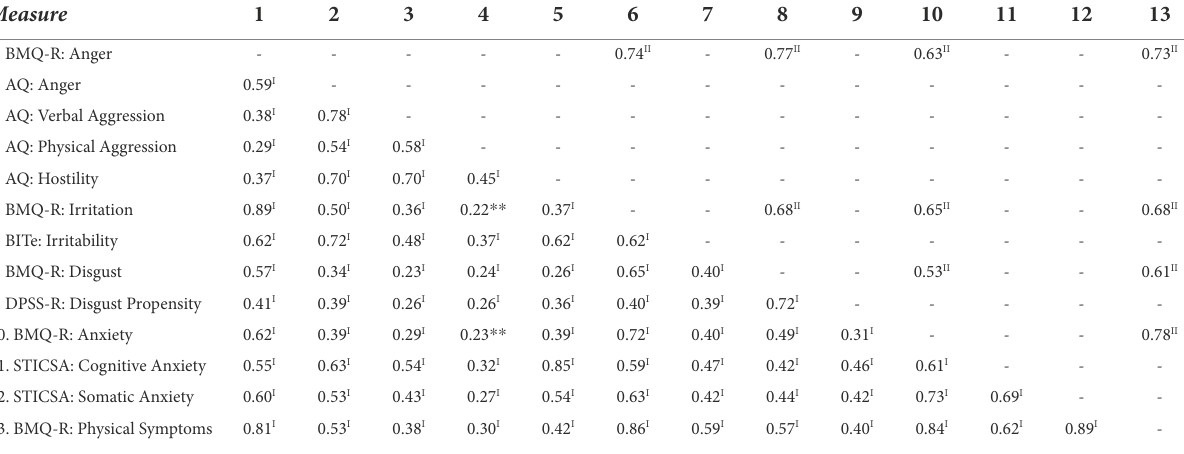
Table 7 Latent (study 1) and Spearman’s (study 2) intercorrelations of misophonic symptoms from the domain misophonic emotional